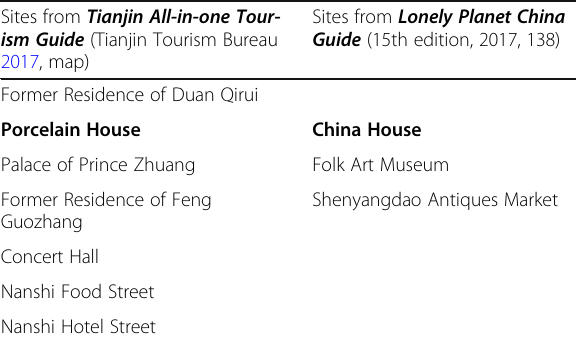
Table 1 Table comparing the sites appearing on two maps of Tianjin published in 2017 (sites common to both are in boldface) Sites from Tianjin All-in-one Tour- ism Guide (Tianjin Tourism Bureau